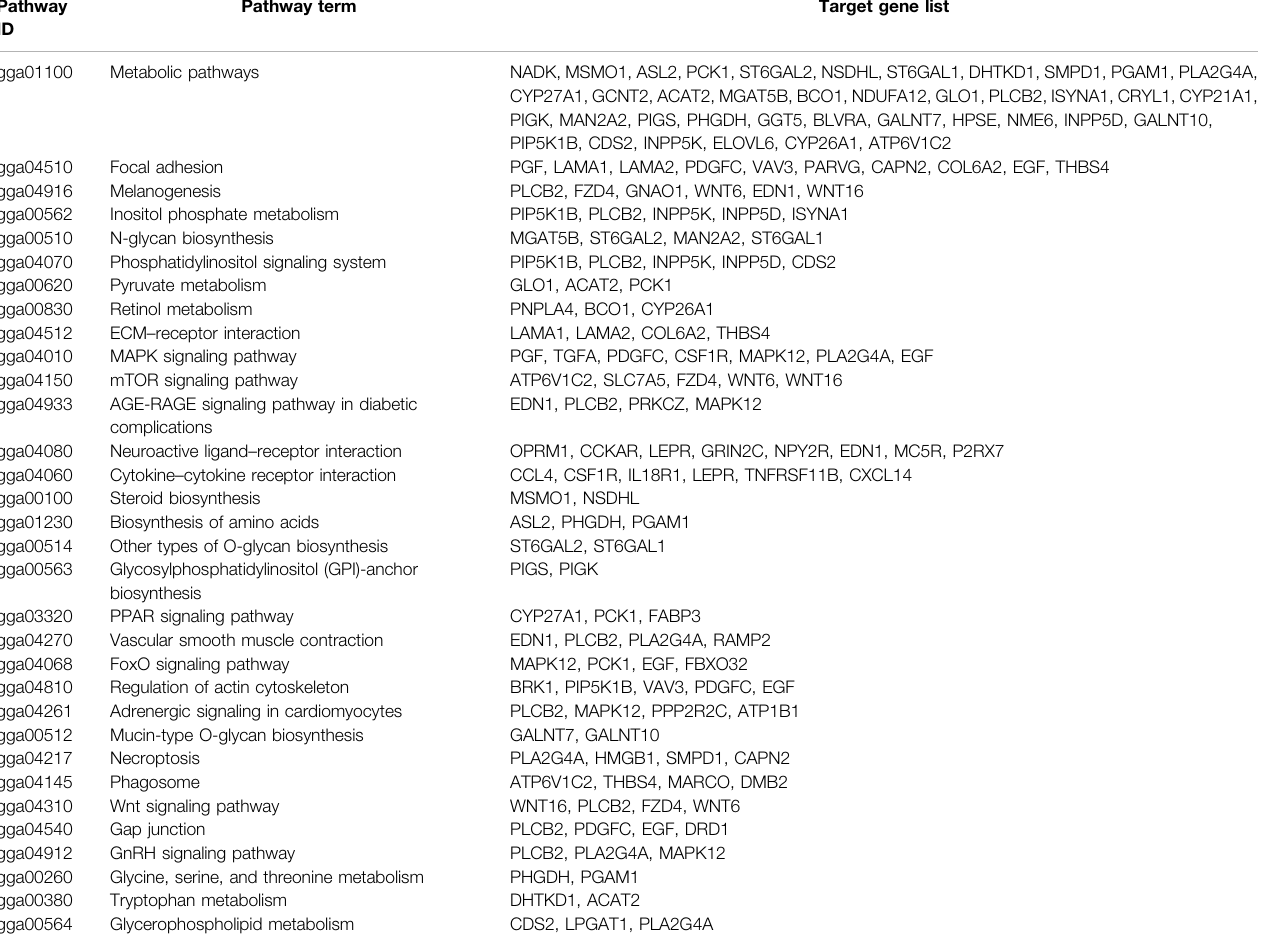
TABLE 1 | Signi fi cantly enriched pathways with functions in follicle development. Pathway